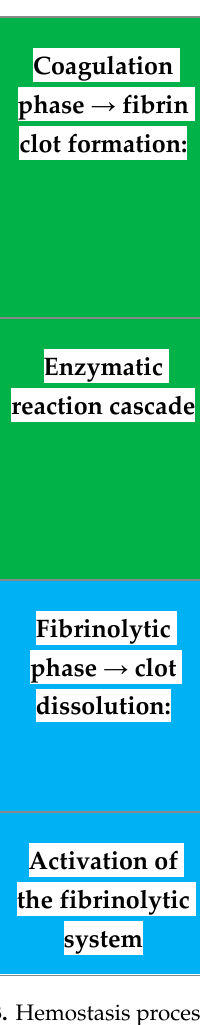
Figure 3. Hemostasis process phases. Table 1. Most common antiplatelet drugs with clinical indications and adverse effects.